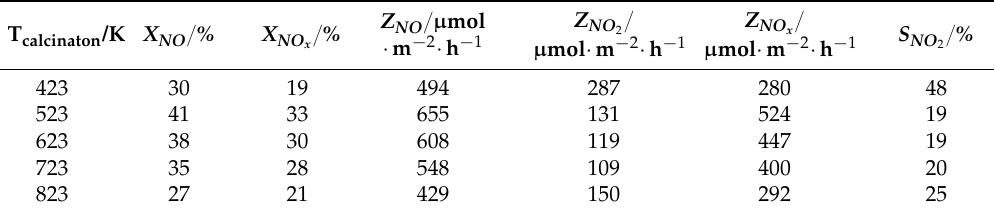
Table 4. Conversion of NO (X NO ) and of NO x (X NO NO removed (Z NO q , amount of NO 2 formed p Z NO photocatalytic oxidation of NO over different TiO 2 and TiO 2 /ZSM-5 composite catalysts after 24 h UV irradiation (5 g TiO 2 or composite, 1000 ppb NO, 50% relative humidity, 3 dm 3 ¨ min ´ 1 total